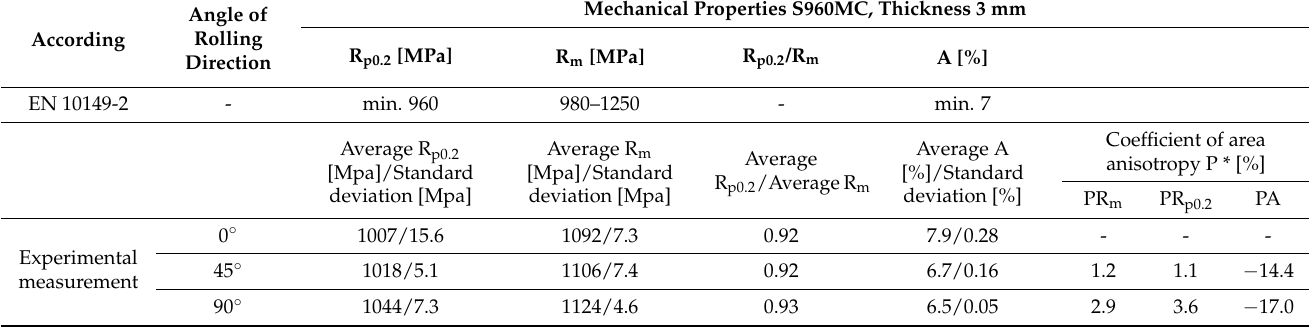
Table 2. Mechanical properties of S960MC